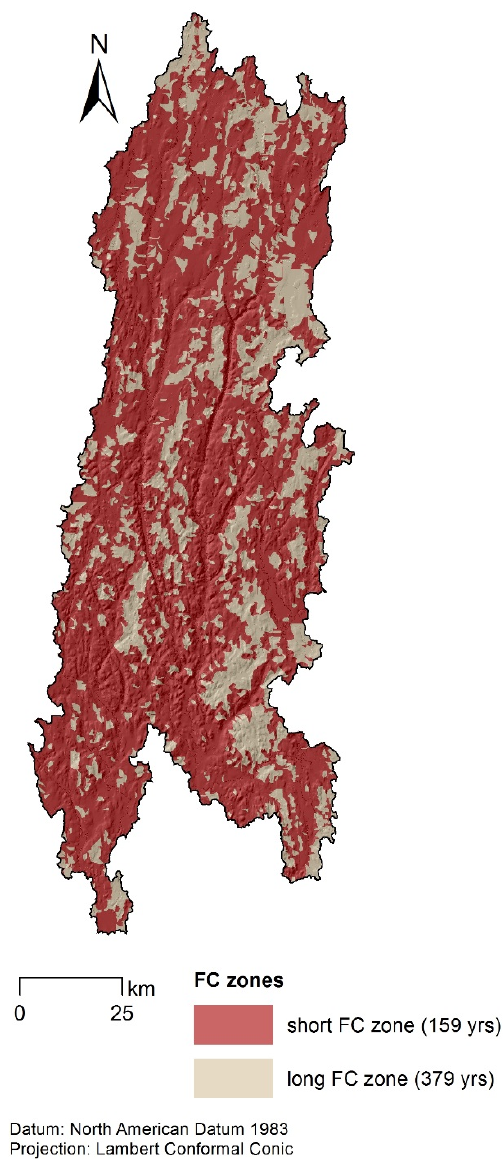
Figure 7. Predicted FC spatial distribution as presented in Figure 6b, grouped into short (159 years) and long (379 years) FC zones. Topography is presented in background hillshade.